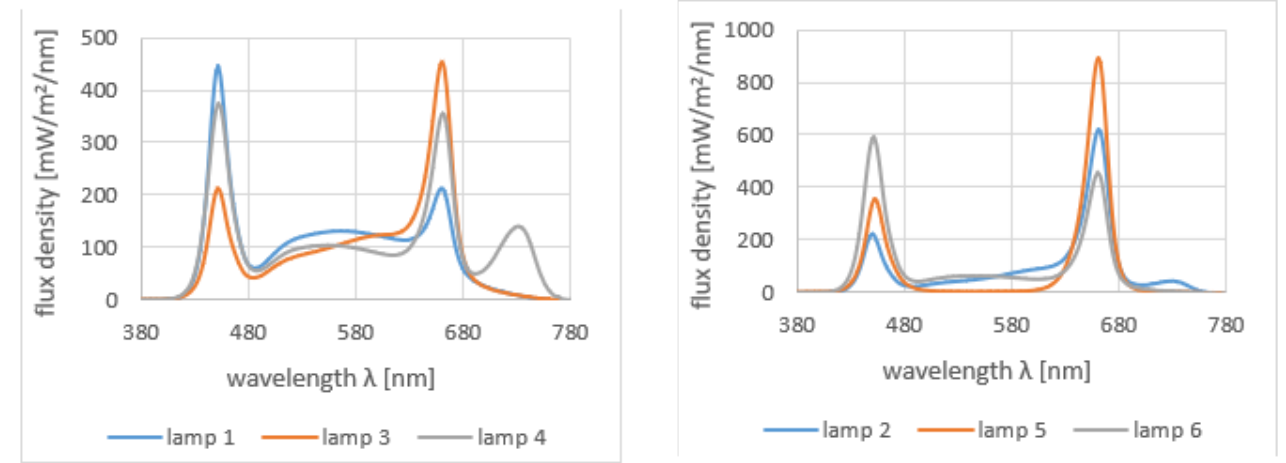
Figure 2. Spectral characteristics of the lamps used in mint cultivation. Table 1. The measured PPFD values for the applied